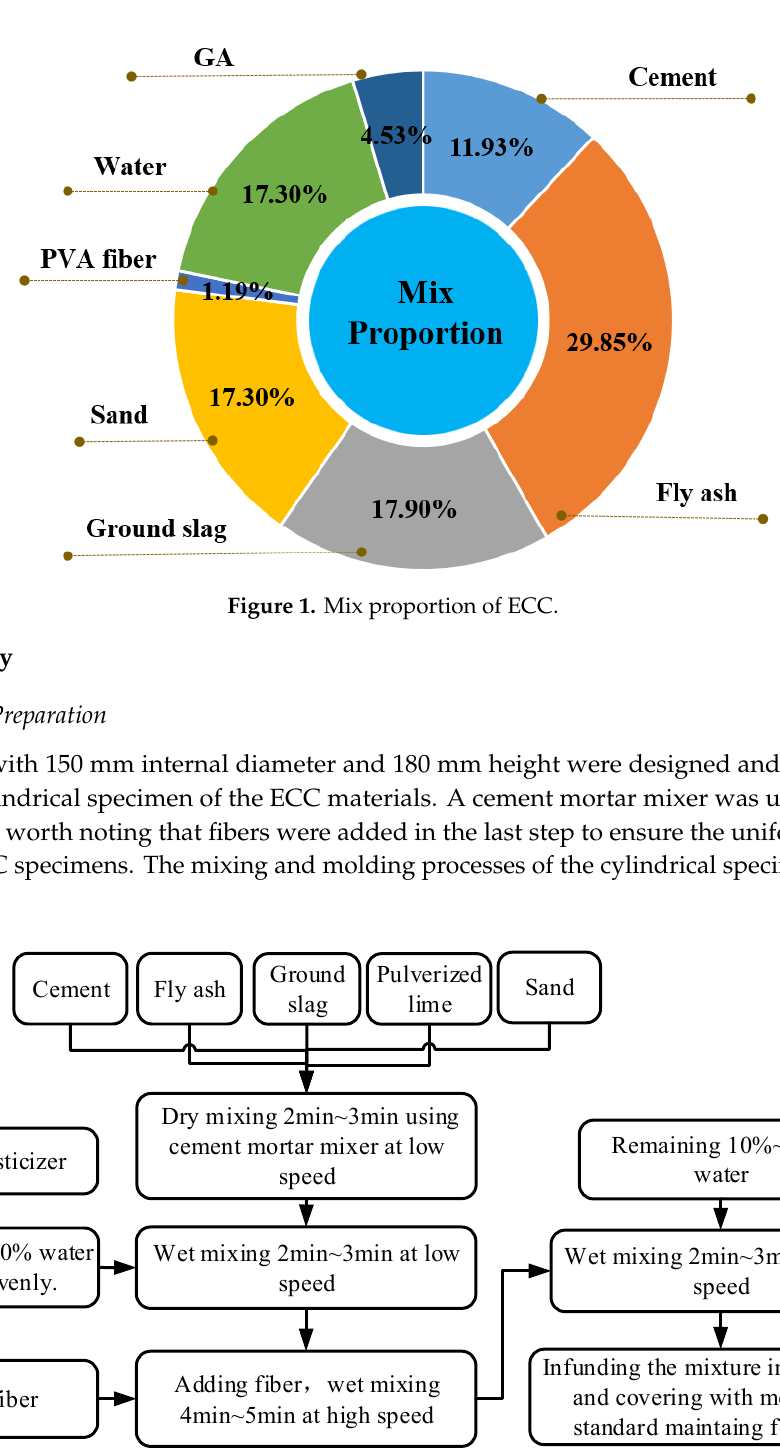
Figure 2. Engineered cementitious composites (ECC) mixture mixing and molding process.